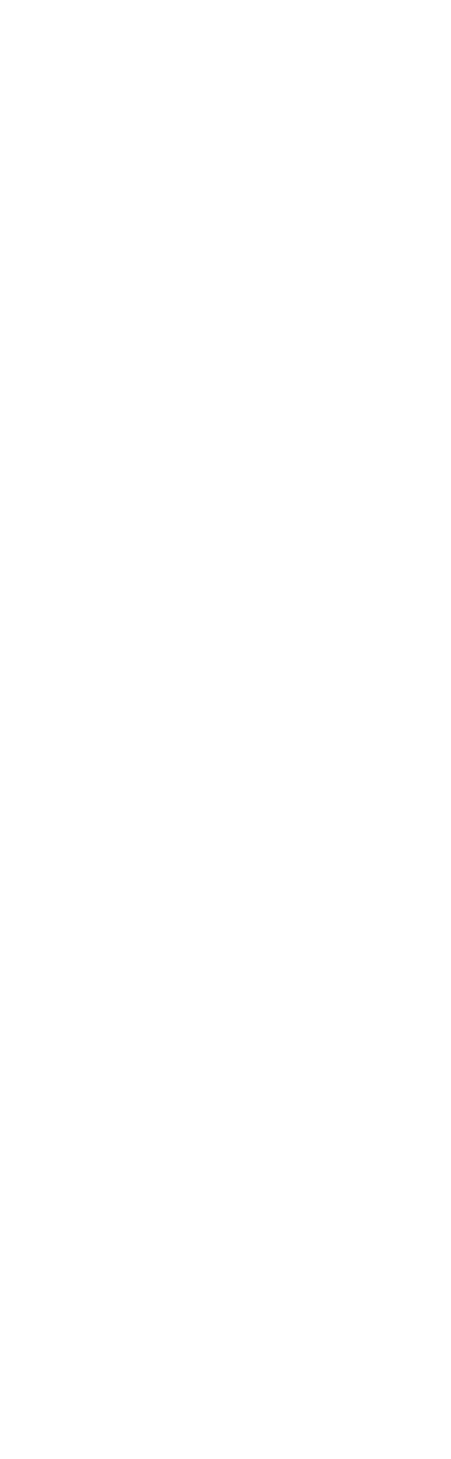
Figure 3. Maximum likelihood phylogenetic tree of full-length csy3 gene sequences of clinical CriePir P. aeruginosa isolates and reference isolates from Pseudomonas genome database. Bootstrap test (1000 replicates) was applied, and bootstrap values are shown at the branch nodes. The ST654 sequences identified in this study are marked with black circle. Sequences identified in this study are indicated by the isolate names and the reference sequences, by GenBank accession number .